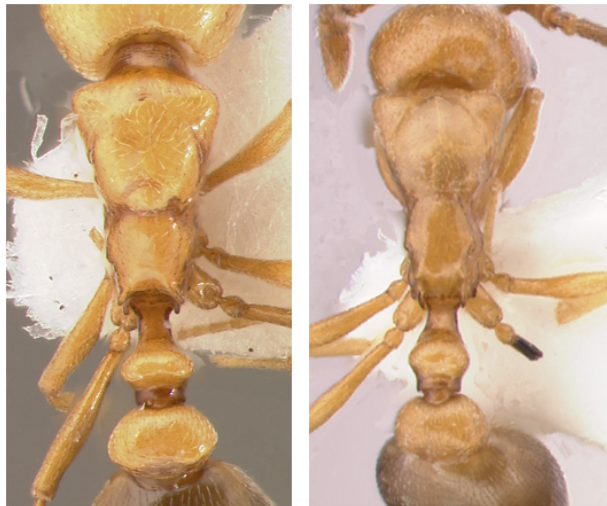
Figure 1 - Dorsal view of the alitrunk of wingless males of the ants Cardiocondyla shuckardi (left, from Ilafy) and C. venustula (right, from uThukela valley, South Africa; same ant as in Heinze et al., 2013) (photos by Christiana